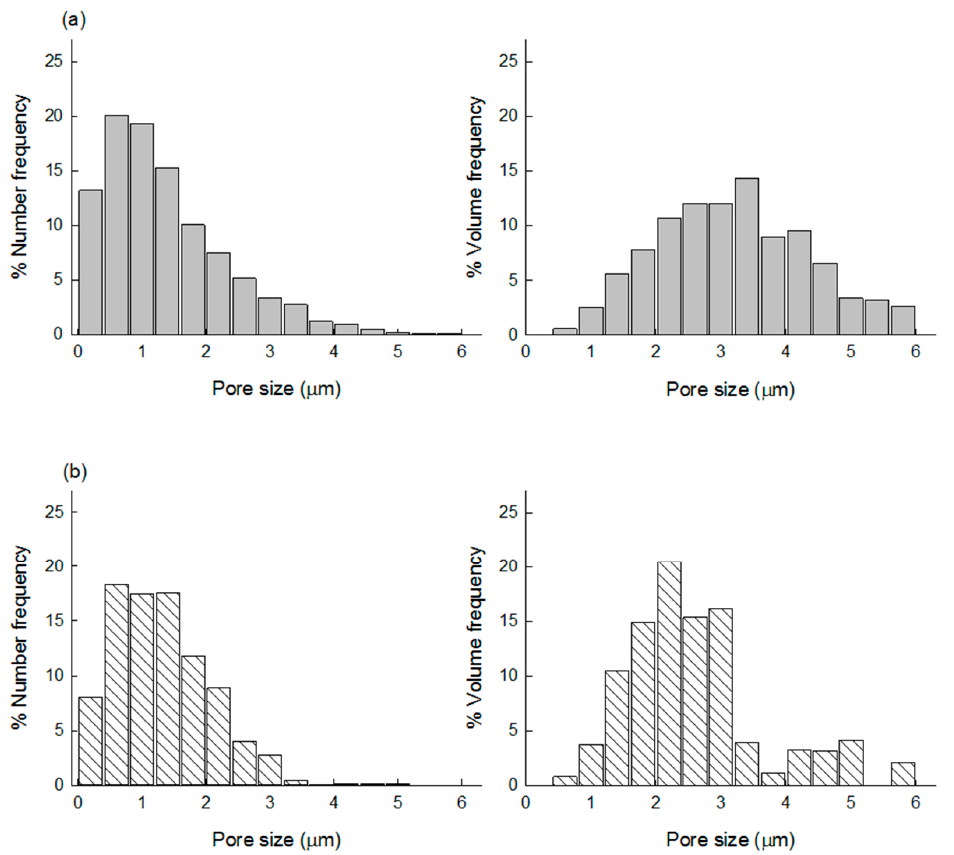
Figure 3. The pore size distributions of spongelike PLGA microspheres prepared using ( a ) 3 mL or ( b ) 7 mL of the ammonia solution. The microsphere porosity is determined by the amount of the ammonia solution used to trigger ammonolysis of isopropyl formate, the dispersed solvent of PLGA.